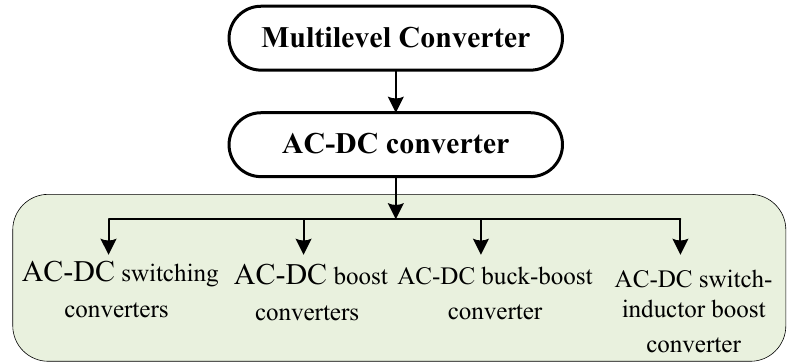
Figure 25. Multi-channel of EMR generators system [130]. Reprinted with permission from ref. [130]. Copyright 2015 IEEE.